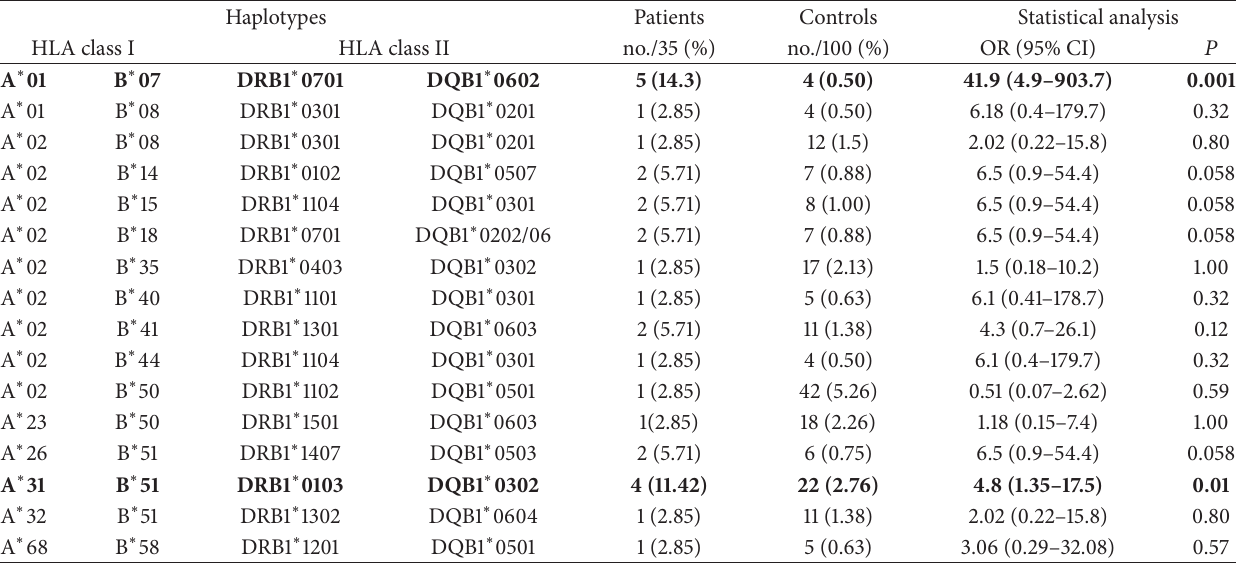
Table 3: Frequency of HLA haplotypes in autistic children and controls.